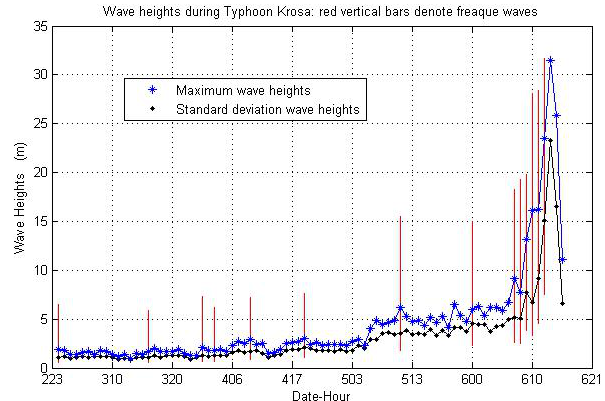
Figure 7. Time history of wave heights during Typhoon Krosa. For the three digit numbers on the abscissa, the first number is the day of October and the next two digits give the corresponding hour. The red vertical bars denote where freaque waves might have occurred.